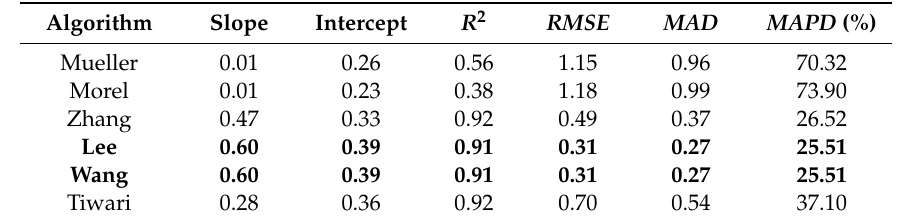
Figure 2. Scatterplots of in situ and model retrieval K d (490) values. Table 3. Statistical parameters between the in situ measured and di ff erent model-retrieved K d (490); models with best performing values are in